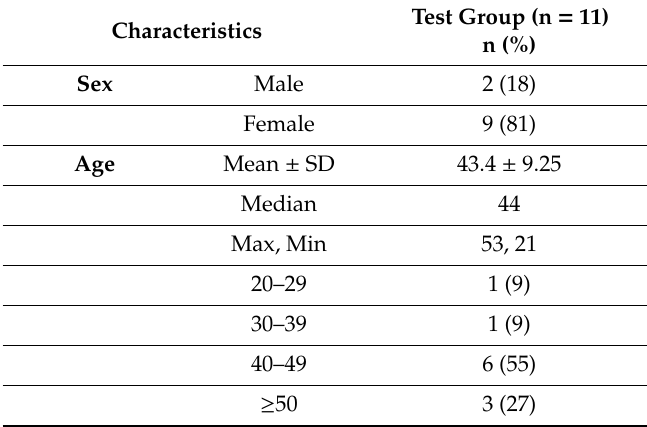
Table 1. Demographic characteristics of the subjects.